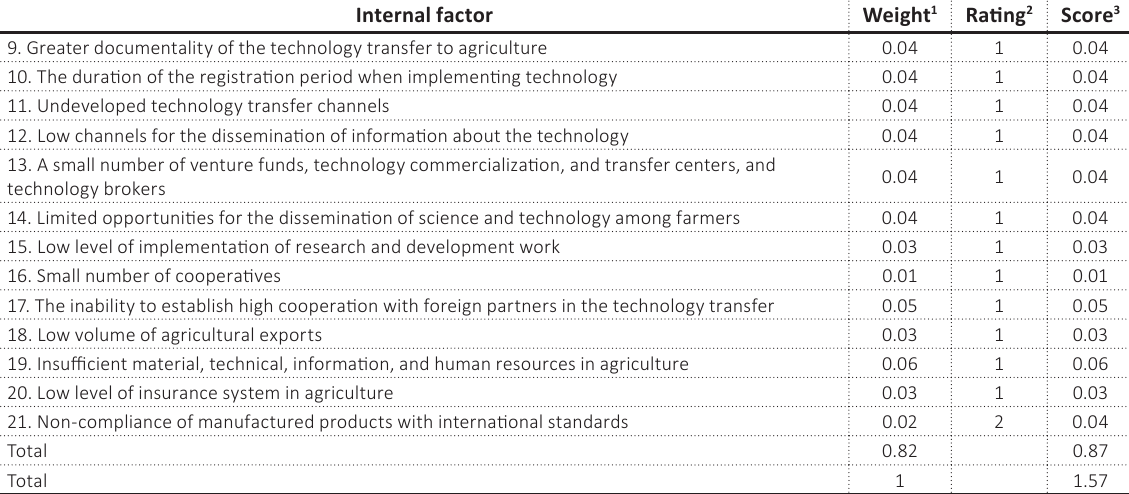
Table 2 (cont.). Analysis of the internal environment of technology transfer in the agricultural sector of